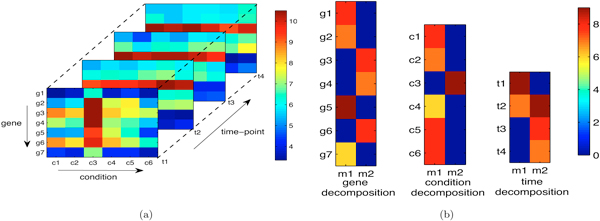
Illustration of module detection by using tensor factorization. (a) higher-order biological (tensor) data; (b) decomposition vectors obtained by factorizing the corresponding tensor.